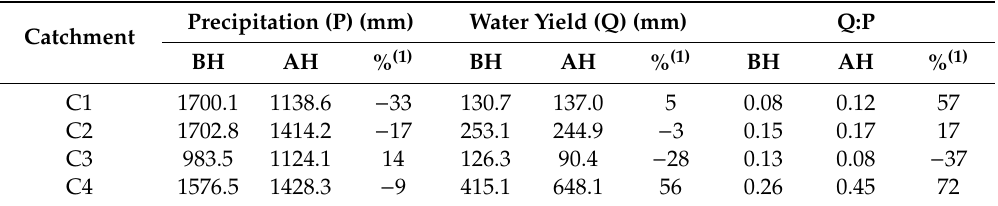
Table 3. Annual precipitation (P), water yield (Q) and Q:P ratio one year before (BH) and one year after (AH) forest harvesting at C1, C2, C3 and C4